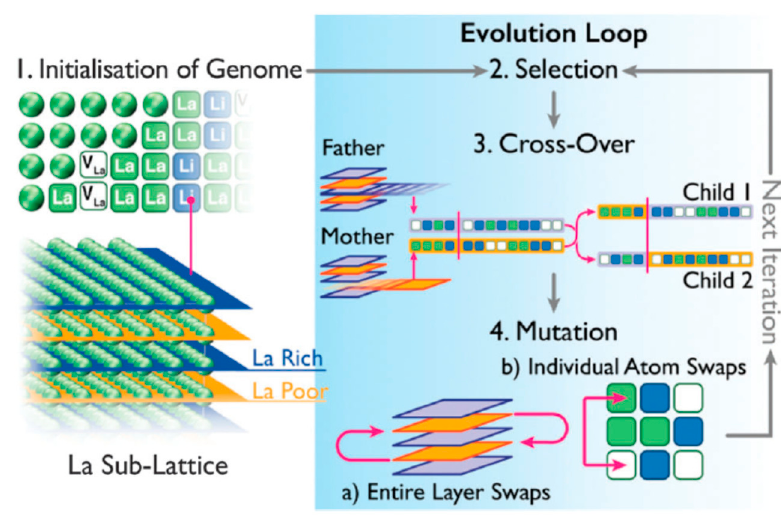
Figure 5. A schematic representation describing how the genetic algorithm favors “inheritance” from structures having high diffusivity to yield the iterative refinement of structures. Reproduced by permission from the Owner Societies [59].